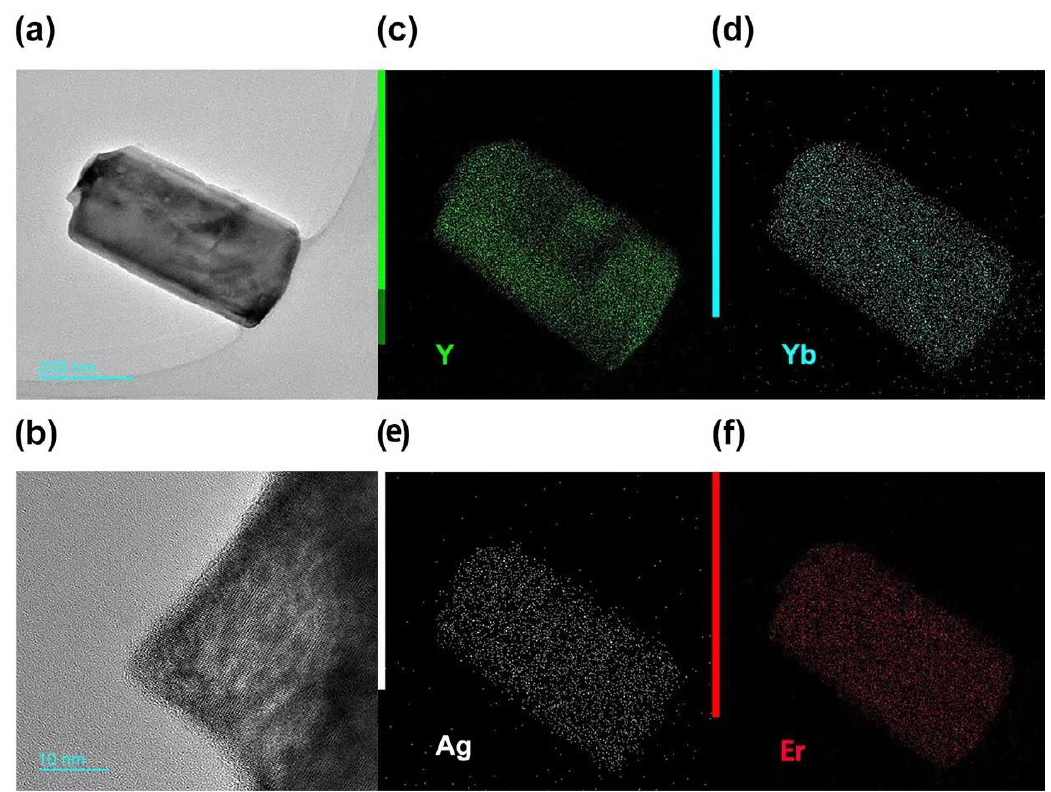
Figure 4. ( a ): TEM image of Ag-UCNPs, ( b ): Lattice of Ag-UCNPs, ( c – f ): mapping of ( a ). Figures 5 and 6 show that the emission bands are observed at 409 nm(purple), 524 nm, 543 nm (green), and 655 nm (red) are due to the 2 H 9/2 → 4 I1 5/2 , 2 H 11/2 → 4 I 15/2 , 4 S 3/2 → 4 I 15/2 and 4 F 9/2 → 4 I 15/2 transitions of Er 3+ ions, respectively. However, it is found that the red and green emission becomes more dominant than the purple emission, which may be due to the cross-relaxation process from 2 G 7/2 to 2 H 9/2 levels. In addition, purple light, green light, and red light show different degrees of enhancement. The SPR absorption peak at 520 nm coincides with the emission band of green light, so the SPR vibration frequency overlaps the luminescence band of UCNPs, the coupling of the emitted light and the SPR will increase the photon localized state density near the surface of AgNPs, thereby increasing the radiation decay rate of Er 3+ , increasing the luminous intensity. Furthermore, the SPR effect of AgNPs produces a local electric field enhancement effect, which enhances the absorption of sensitizers through electric field coupling and also increases the emission